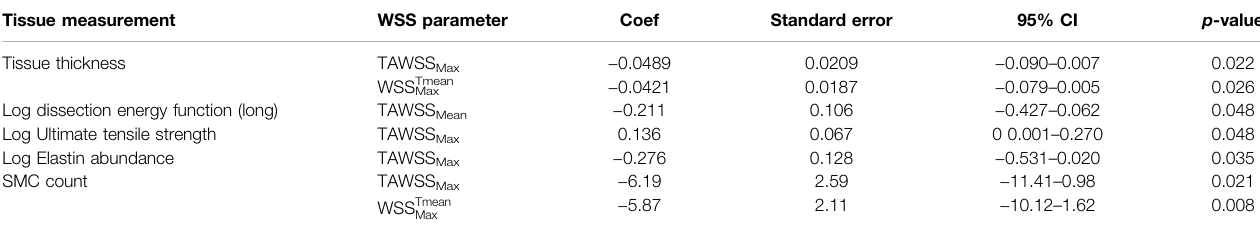
TABLE 4 | Linear regression analysis: comparison of measurements of WSS per ATAA segment and tissue-derived parameters of corresponding segment from patient- speci fi c excised tissue. circ (cid:1) circumferential, long (cid:1) longitudinal, SMC (cid:1) smooth muscle cell. All results are statistically signi fi cant ( p -value < 0.05). Tissue measurement WSS parameter Coef Standard error 95% CI p -value Tissue